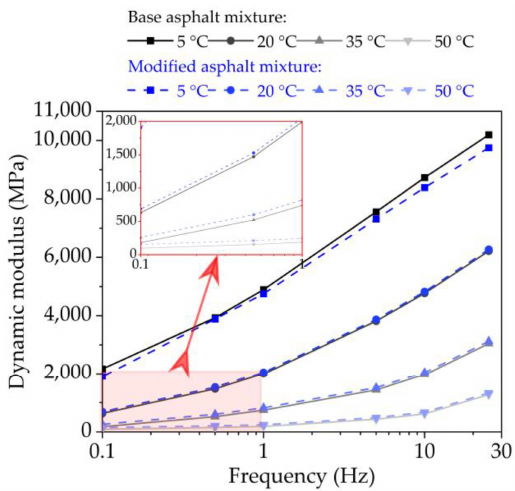
Figure 11. The dynamic modulus of base bituminous mixture and nano-TiO 2 /CaCO 3 modified bituminous mixture at different test temperatures.